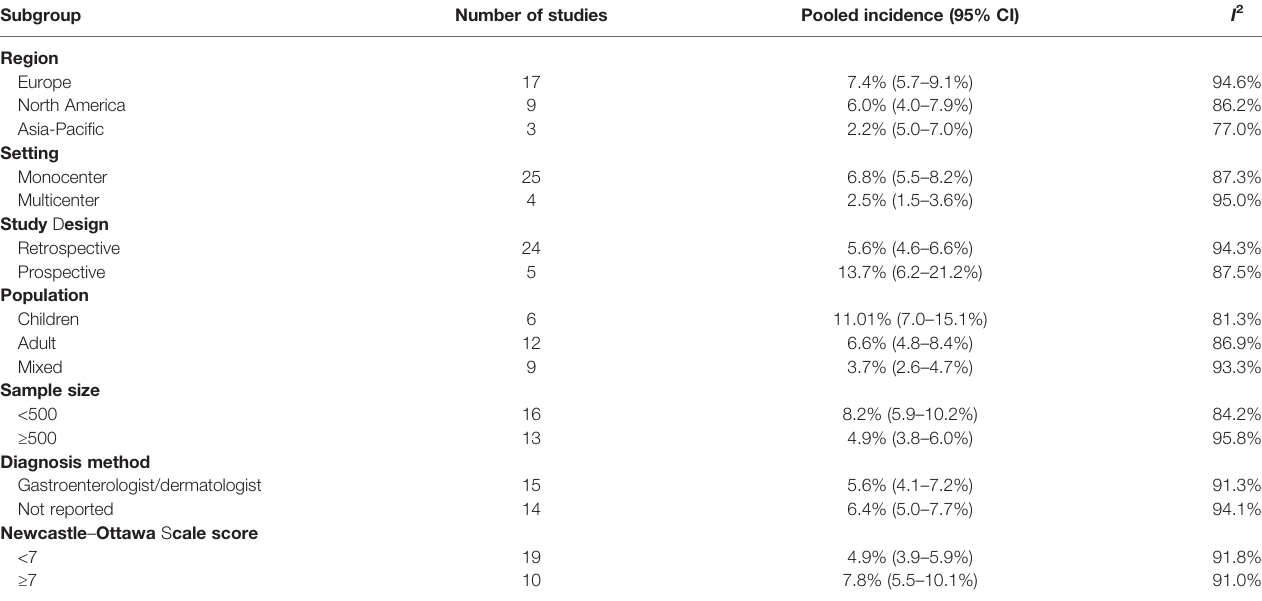
TABLE 3 | Subgroup analyses of pooled incidence of psoriasis or psoriasiform lesions associated with anti-tumor necrosis factor therapy in in fl ammatory bowel disease patients.